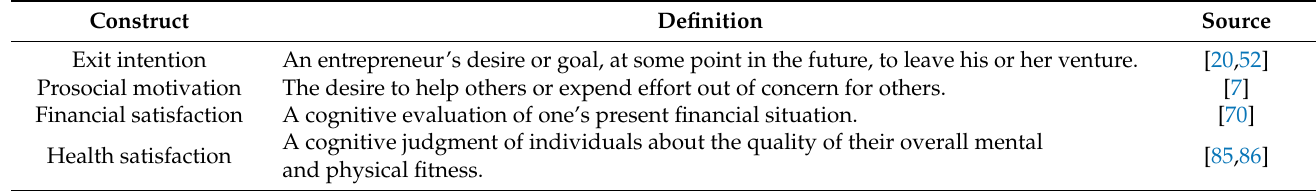
Table 2. Operational